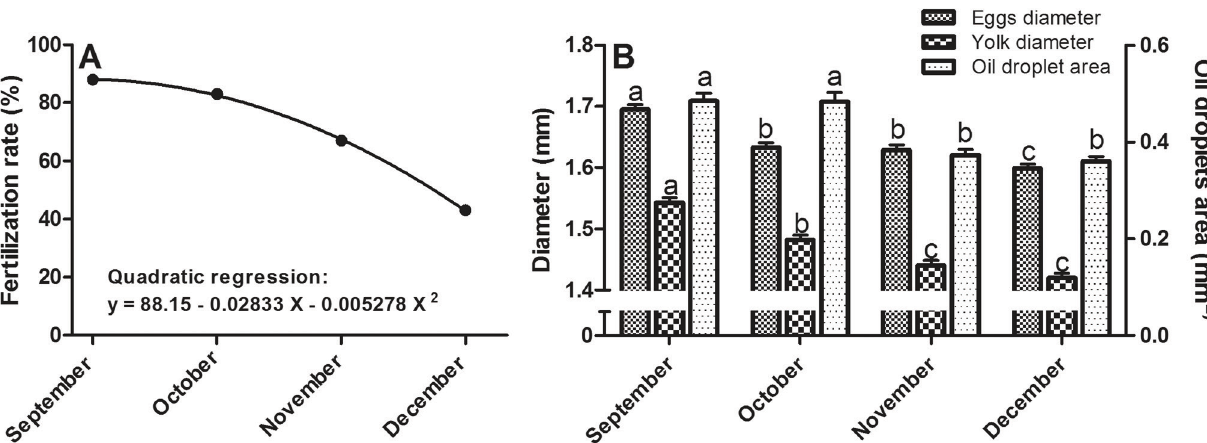
Fig. 2. Pejerrey egg measurements throughout the reproductive season. ( A) Changes of pejerrey fertilization rate, quadratic regression with abscissas in days between 0 (September 10 th ) and 90 (December 10 th ); R 2 = 0.9623. ( B) Changes of pejerrey egg measurements across the reproductive period analyzed. Different letters indicate mean statistical differences. ANOVA followed by Bonferroni’s multiple comparison tests (n = 50; P ≤